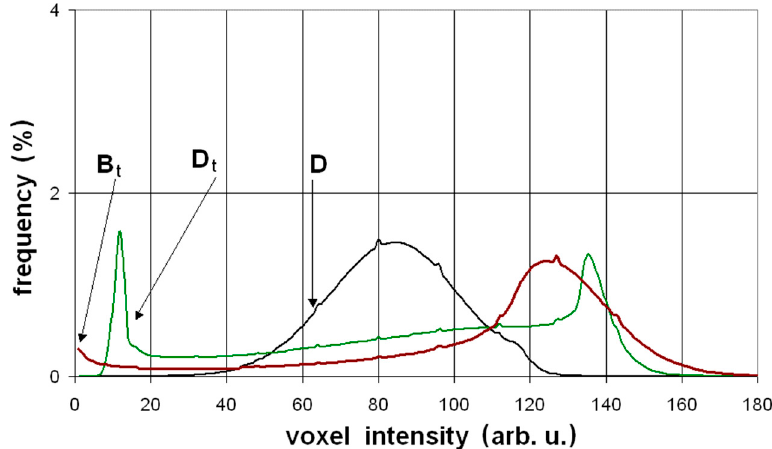
Figure 8. The greyscale brightness distribution (GBD) of all voxels belonging to the three examined specimens: “D”, “D T ” and “B T ”. The occurrence of the delamination processes caused a shift of the affected GBD curves to the left, i.e. in the direction of a region of